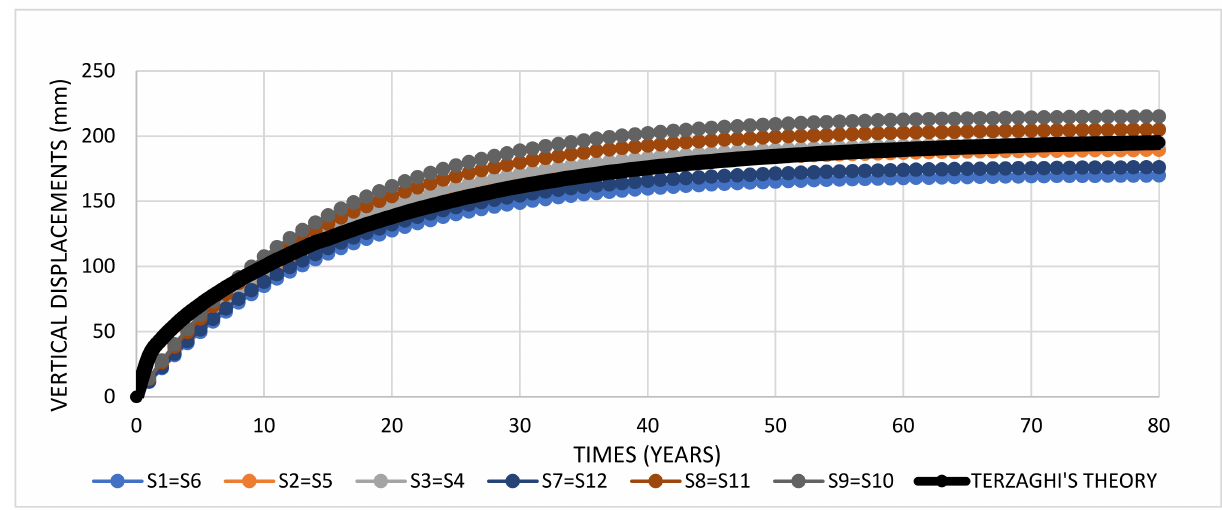
Figure 9. Vertical displacements on footings, for the BEM/FEM coupling, at infinite time.